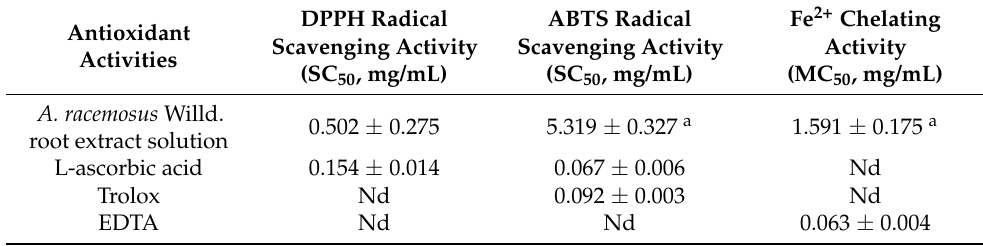
Table 2. Antioxidant activities of Asparagus racemosus Willd. root extract